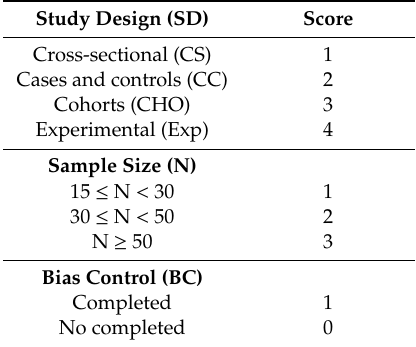
Table 1. Scores of QI items.